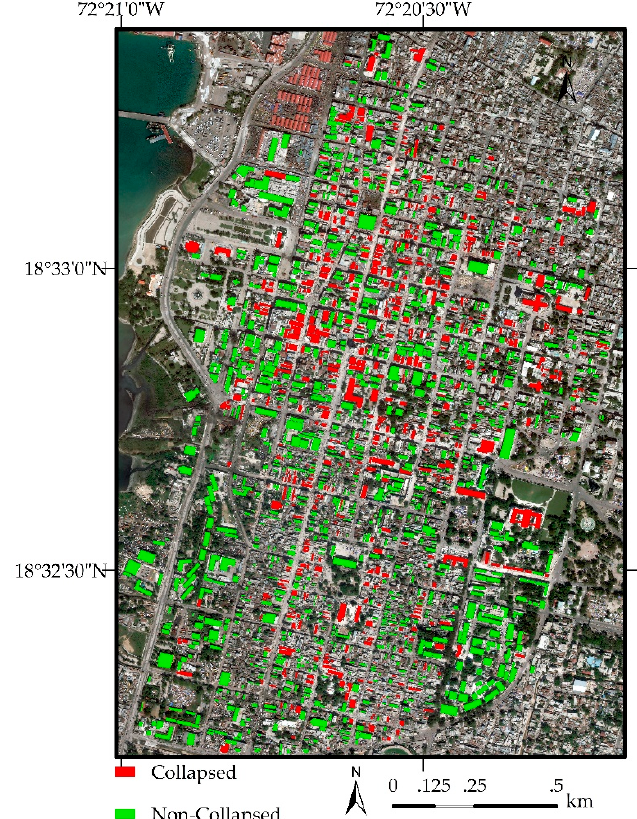
Figure 2. Distribution of collapsed and non-collapsed buildings in the study area. Red indicates collapsed buildings; green indicates non-collapsed buildings.